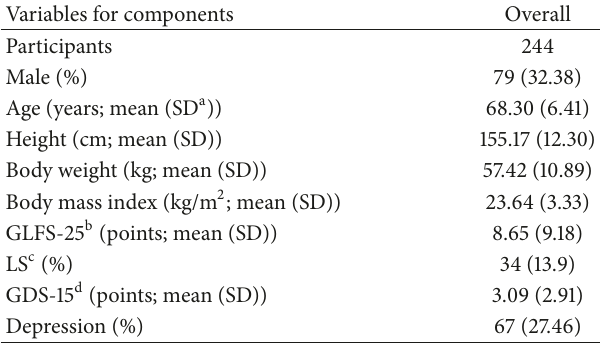
Table 1: Characteristics of the study